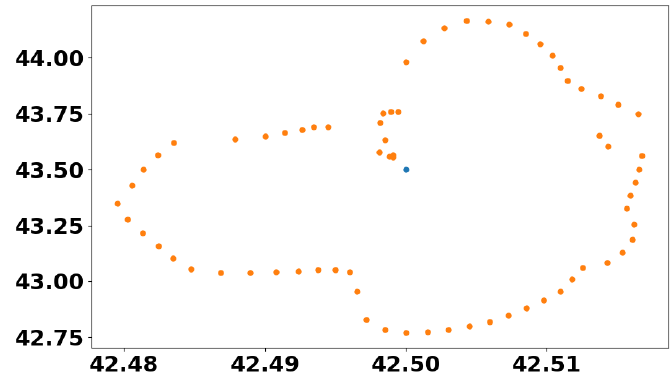
Figure 12. All points that can be reached from ( 42.5 ◦ ,43.5 ◦ ) in 20 min in different